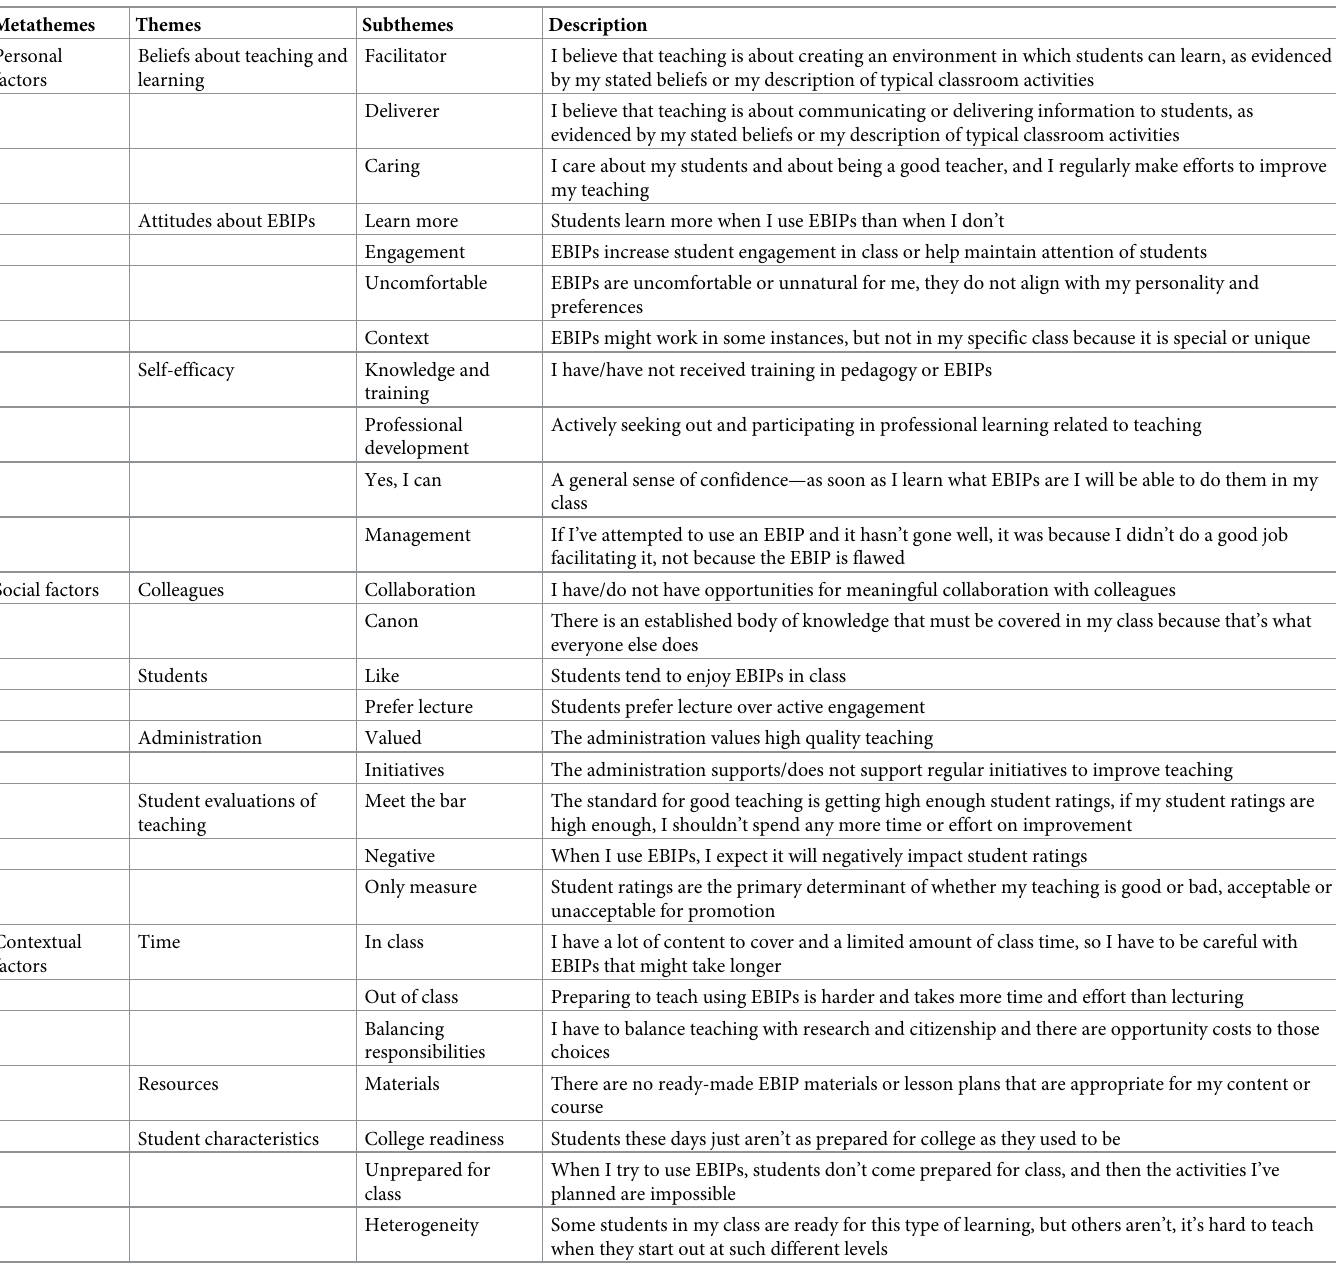
Table 1. Themes about instructional decision-making identified during the analysis of interview